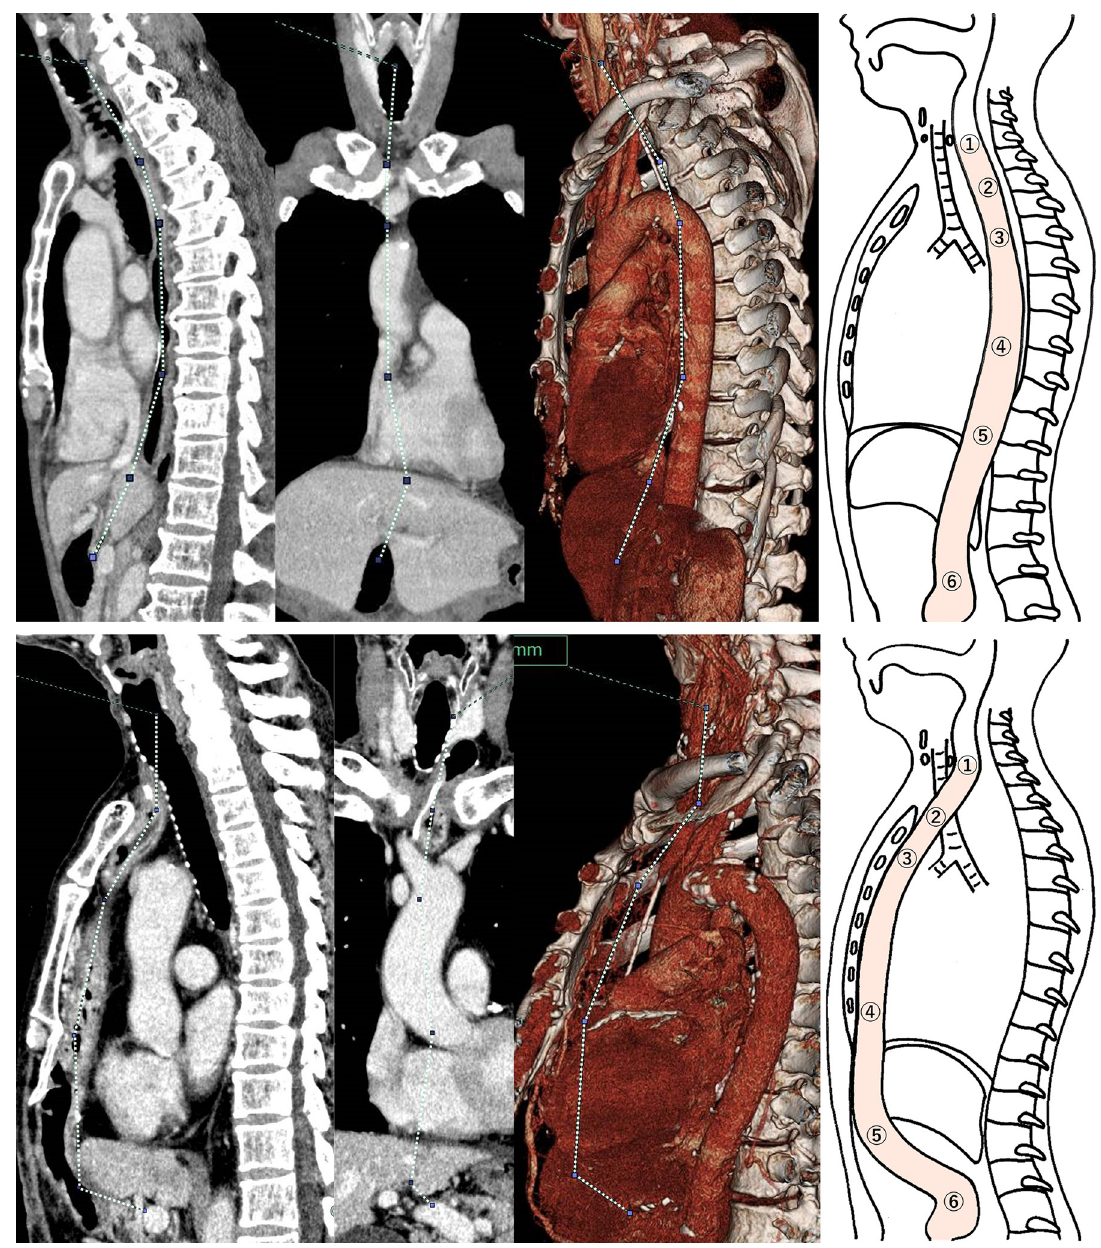
Fig 1. (a) Reference points for measuring the length of the esophagus and stomach and the posterior mediastinal route. ① Cricoid cartilage, ② jugular notch, ③ tracheal bifurcation, ④ middle point between ③ and ⑤ , ⑤ esophageal hiatus, and ⑥ gastroduodenal artery. (b) Reference points for measuring the length of the retrosternal route. ① Cricoid cartilage, ② jugular notch, ③ tracheal bifurcation, ④ lower border of the body of sternum, ⑤ lower border of the left hepatic lobe, and ⑥ gastroduodenal